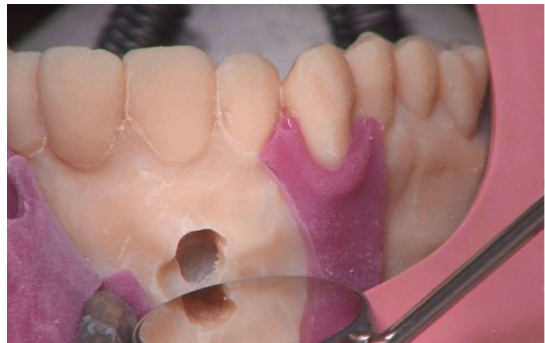
Figure 9. Resected root tip with demarcation to the bone.